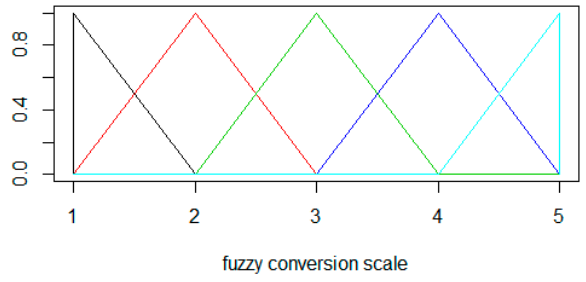
Figure 5. An example of a fuzzy conversion scale.